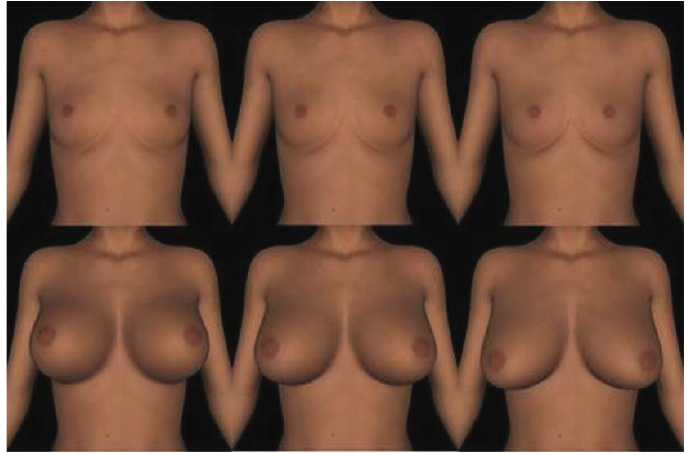
Figure 1. Examples of breast stimuli used. The top row depicts stimuli with three levels of inter- mammary distance for A-cup breasts, and the bottom row depicts three levels of ptosis for D-cup breasts.